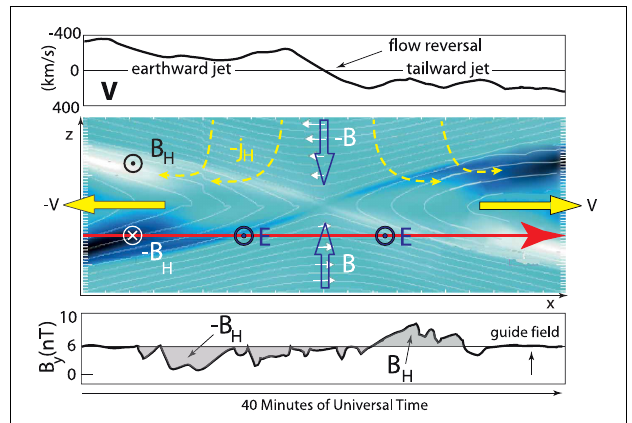
FIGURE 6 | Hall fields, observation and simulation. Central panel: Two-dimensional simulation of reconnection including different electron and ion dynamics (data taken from Vaivads et al. [131]). Shown is only the magnetic field with background field lines drawn in thin white. Dark blue regions indicates positive Hall- B y , white regions negative Hall- B y . The Hall fields concentrate along and inside the separatrices and boundaries of the two plasmoids where the Hall electrons (dashed yellow lines) turn away from the X point. Hall fields twist the original magnetic field. They can be considered as self-generated magnetic guide fields in the ion diffusion region. Such guide fields embedded into the convection electric field E y (black circles) may accelerate electrons out of the plane thereby strengthening the current in the ion diffusion region. Open arrows show convective inflow, yellow arrows outward jetting of plasma. Top panel: Plasma velocity measured along the spacecraft orbit (long red arrow in the central panel) in Earth magnetotail during a substorm reconnection event. Flow reversal is seen during passage near the X point indicating the two plasma jets emanating from X. Bottom panel: Measured out-of-plane (Hall) magnetic field during the flow reversal event exhibiting the antisymmetric geometry of the Hall field (data (schematized) after original measurements of Øieroset et al. [37]). Note the presence of a weak (6nT) magnetic guide field in y direction.